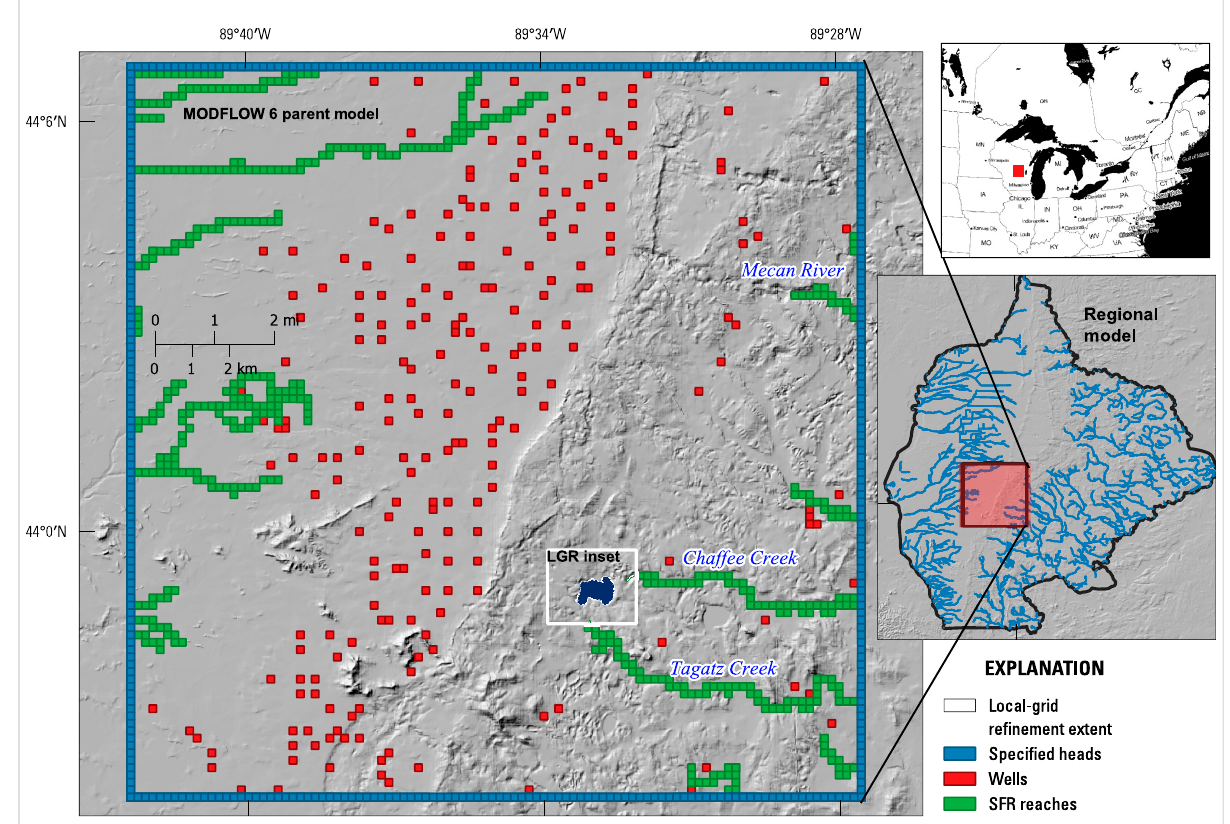
FIGURE 2 The full Pleasant Lake model domain with location map, showing the relationship between the regional, intermediate and LGR inset models, as well as the irrigation wells